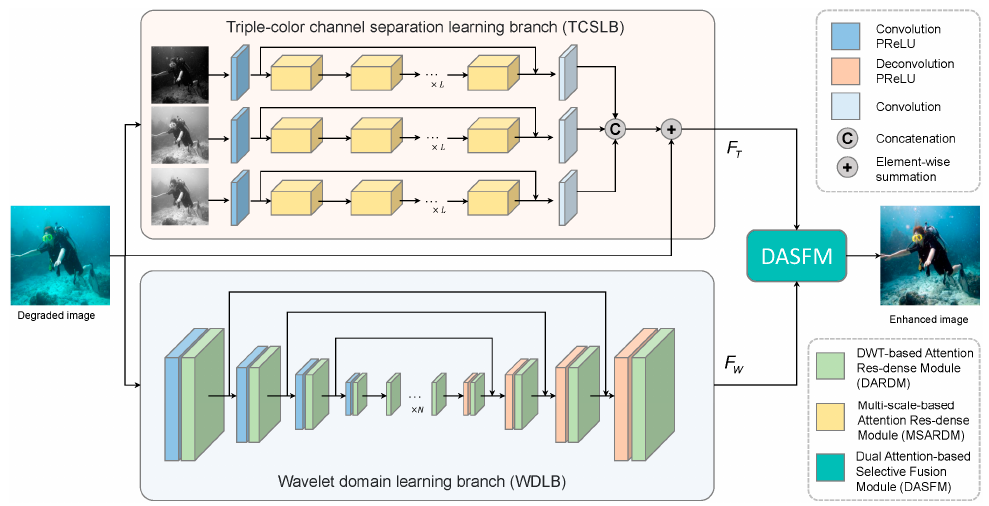
Figure 2. The architecture of our proposed DBFNet for UIE.